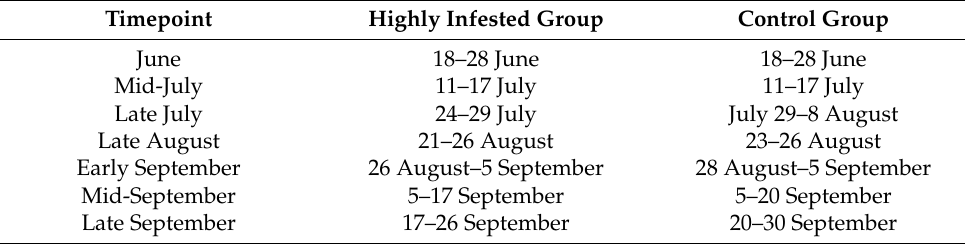
Table A2. Timeframes used for the comparison of daily varroa mite fall per